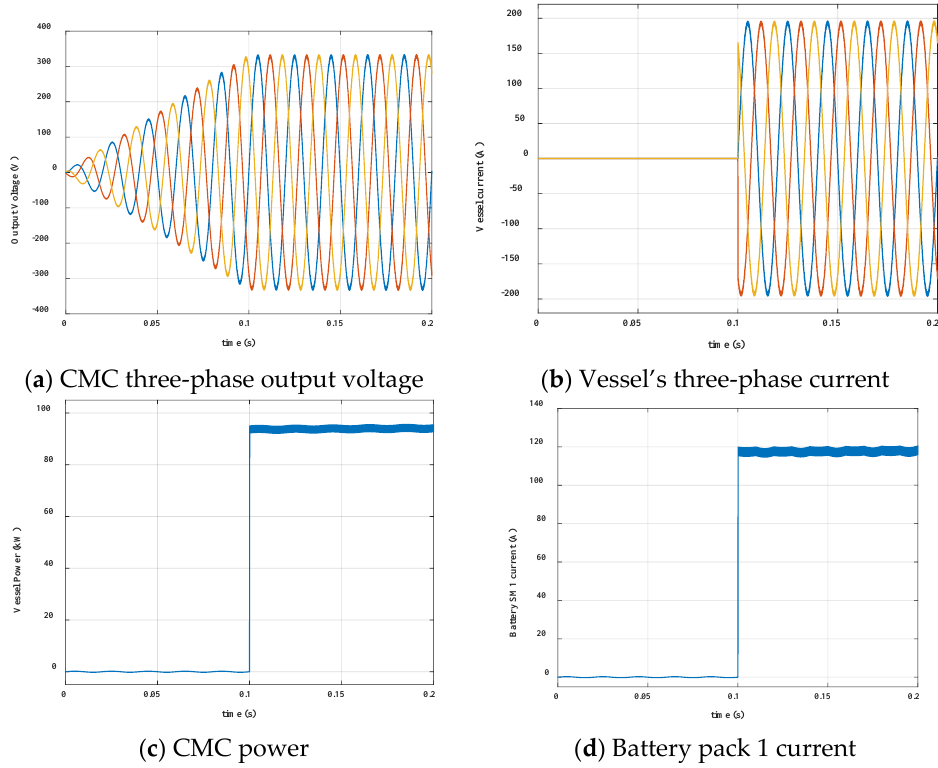
Figure 23. Mode 3 (from batteries to vessel) MATLAB/SIMULINK simulations.